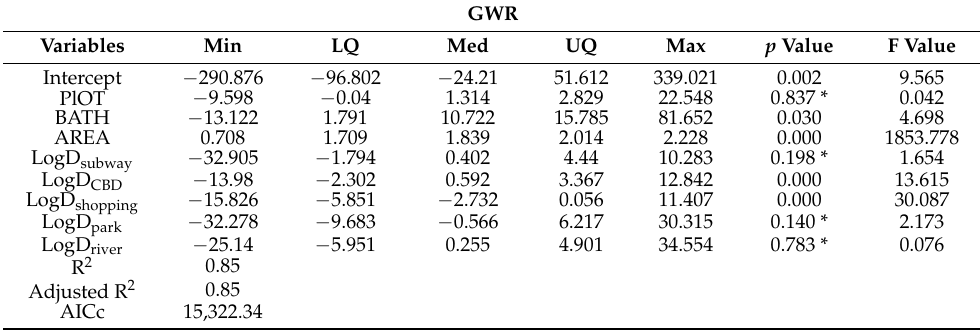
Table 4. The distribution of the localized coefficient estimates for the GWR model (B = 2221).